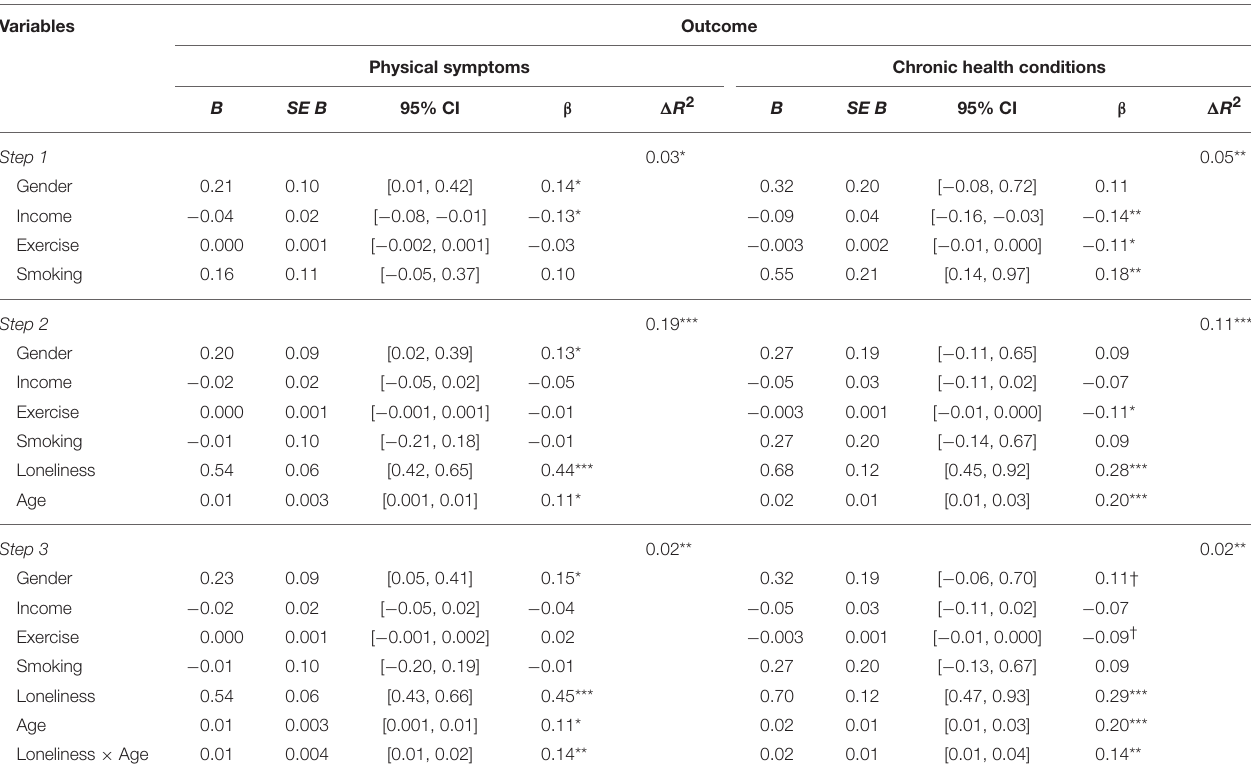
TABLE 2 | Summary of hierarchical regression analysis for variable predicting physical symptoms and chronic health conditions in Study 1.